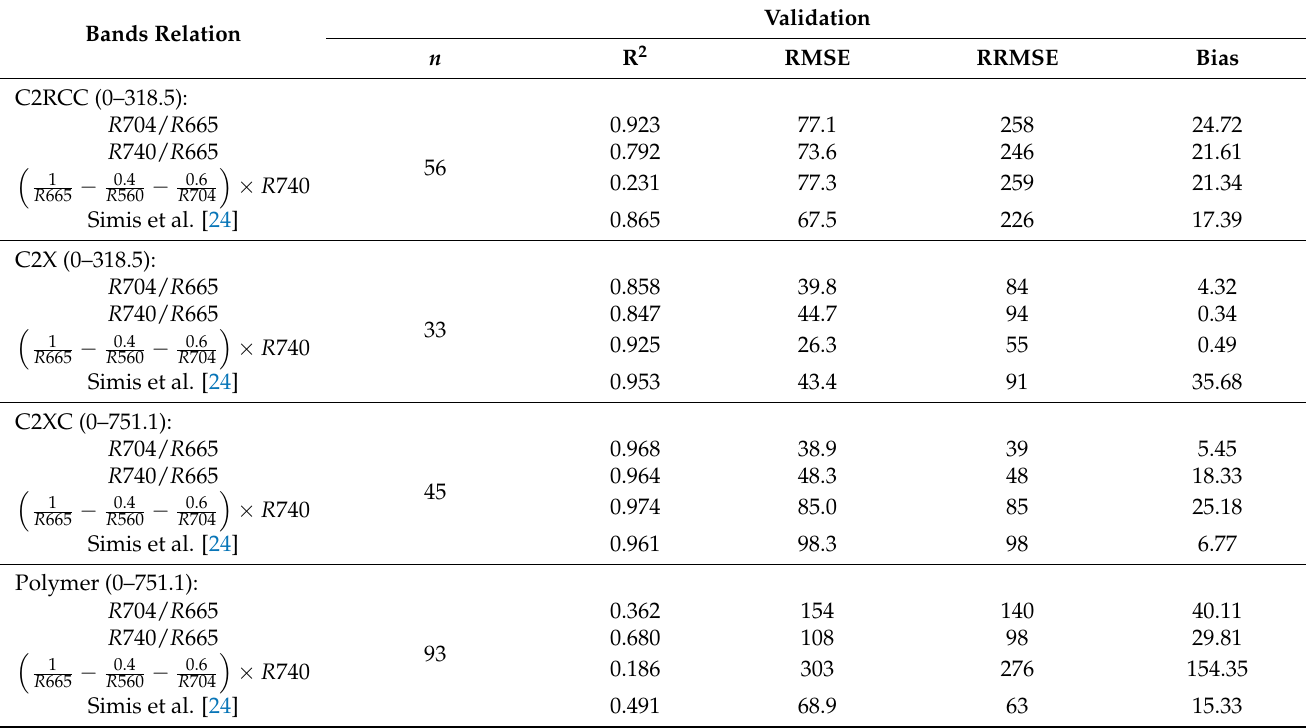
Table A7. PC validation results for in situ spectrometry waters quality algorithms and AC